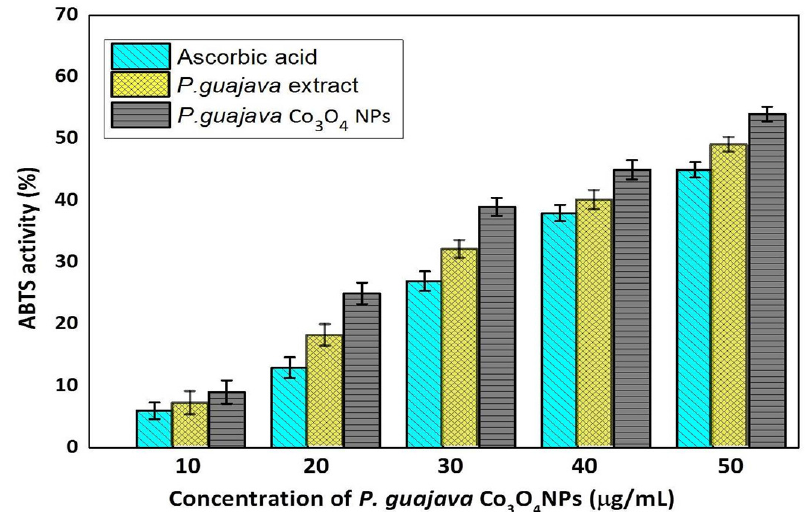
Figure 8. Antioxidant activity of Psidium guajava Co 3 O 4 NPs using ABTS. Results are represented as mean ± SD, triplicate measures.